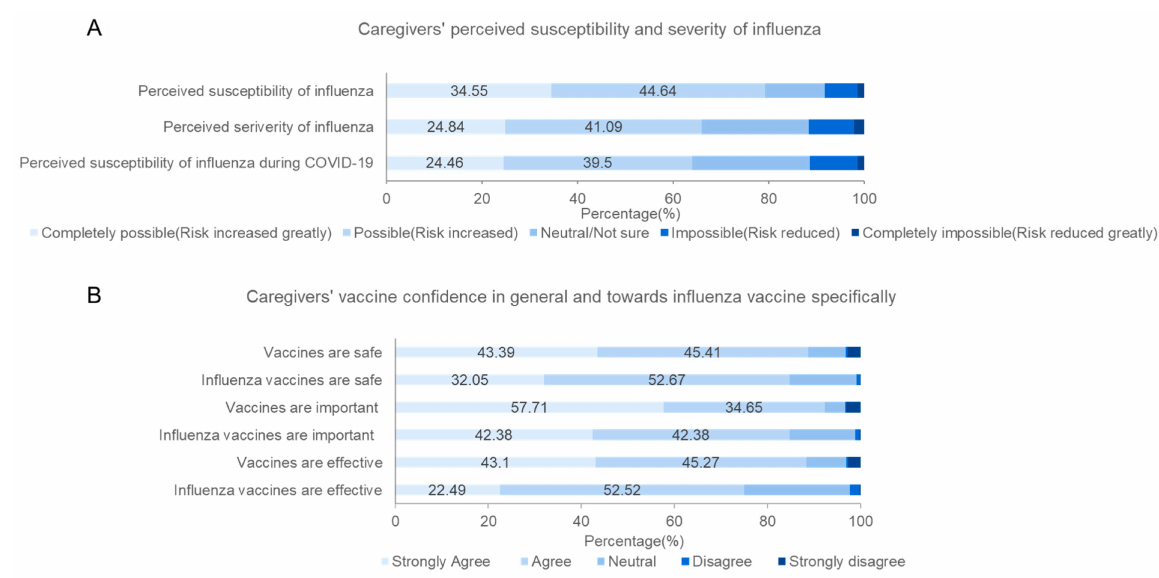
Figure 2. Caregivers’ perception on influenza and influenza vaccine: ( A ) Caregivers’ perceived susceptibility and severity of influenza; ( B ) Caregivers’ vaccine confidence in general and towards influenza vaccine specifically.